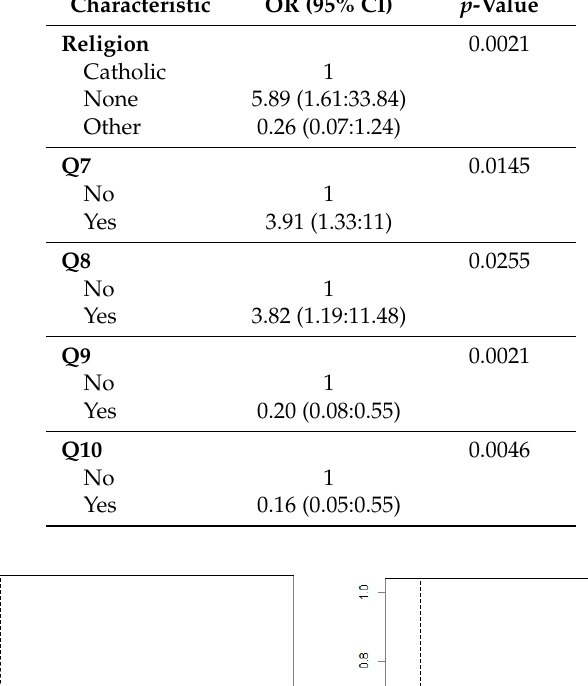
Table 3. Multivariate analysis ( n = 349). Characteristic: variable taken into account; OR (95% CI): odds ratios with 95% confidence interval; p -value: LR p -value.